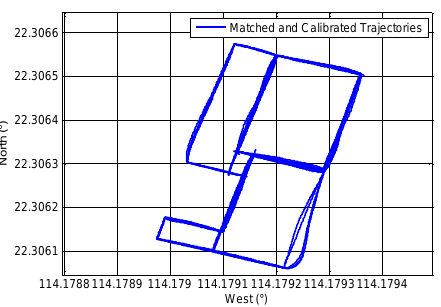
Figure 4. Matched and Calibrated Crowdsourced Trajectories In addition, the accuracy of calibrated trajectories are compared with ground-truth indoor network, and the evaluated precision of calibrated trajectories is calculated